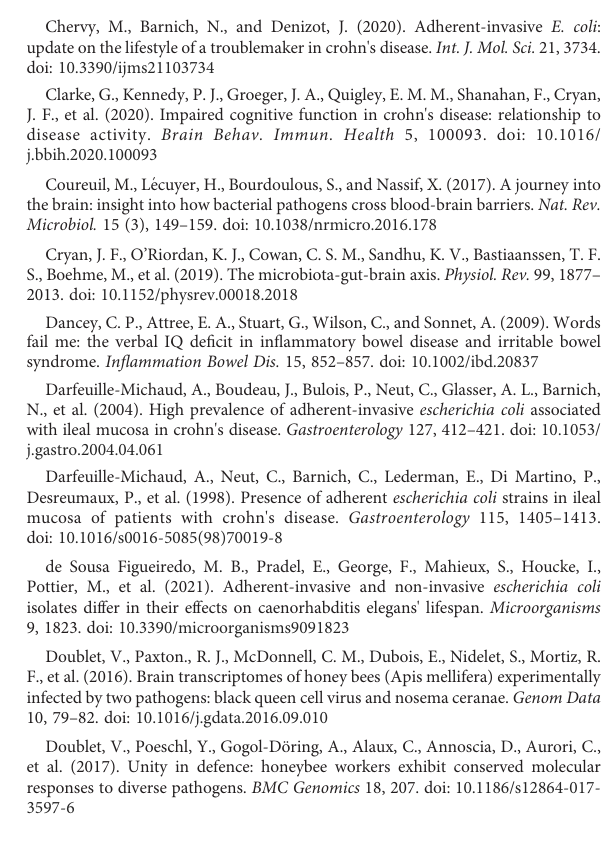
SUPPLEMENTARY FIGURE 1 Histopathologic evaluation with hematoxylin and eosin staining of the honeybee midgut in the different groups (Bars = 50 m m). SUPPLEMENTARY FIGURE 2 (A) Up-regulated metabolites enriched in KEGG pathway in the LF82 group. (B) Enrichment pathways of metabolites upregulated in LF82 in the fecal metabolic pool of patients. SUPPLEMENTARY FIGURE 3 (A) Volcano map of differentially expressed genes (DEGs) in the honeybee brain between LF82 and MG1655 (n = 3). (B) Representative enriched KEGG pathways downregulated in the LF82 group, compared with the MG1655